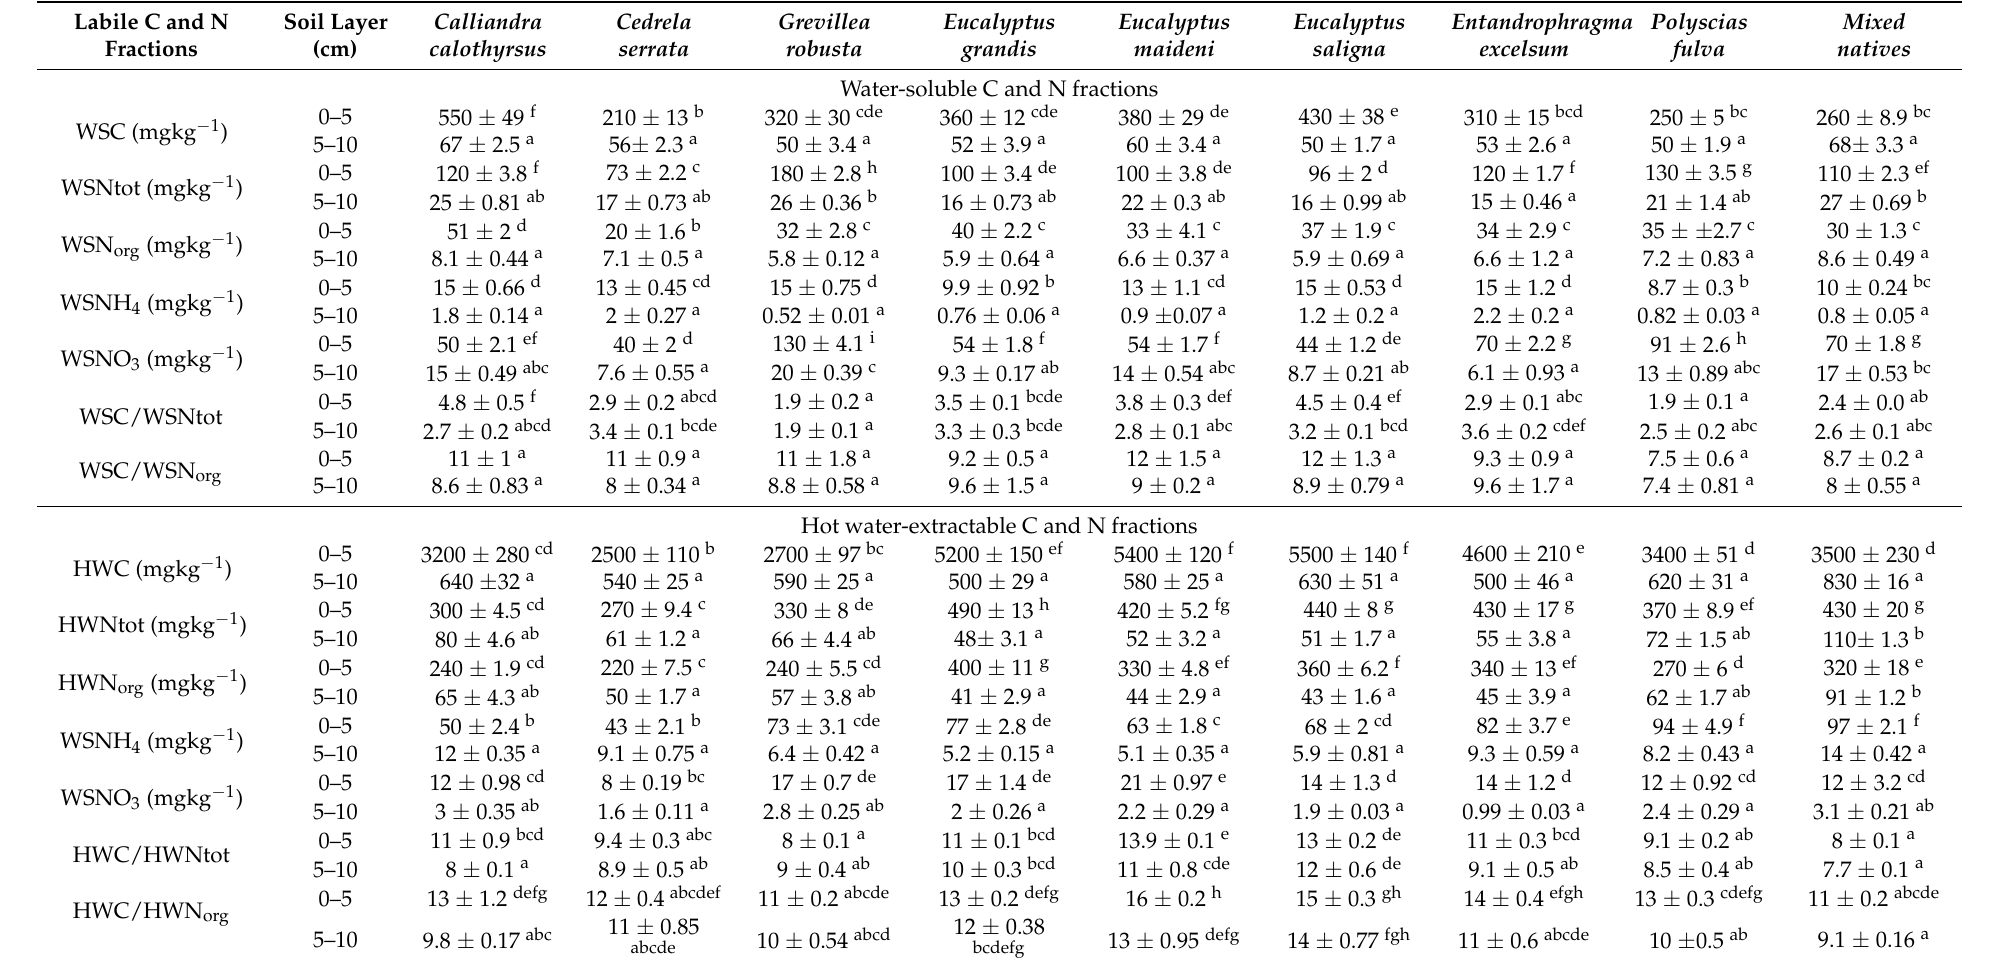
Table 1. Measured waters’ C and N under different tree species in the Arboretum of Ruhande (means ± SEM). Different letters within one parameter denote significant differences between tree species and soil depths (mixed linear models, Tukey’s HSD, p <